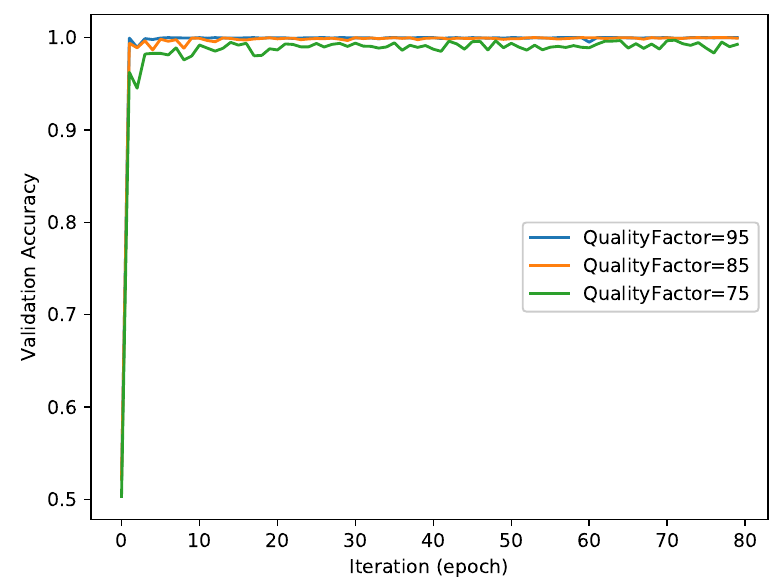
Figure 6. Validation performance of the proposed method.